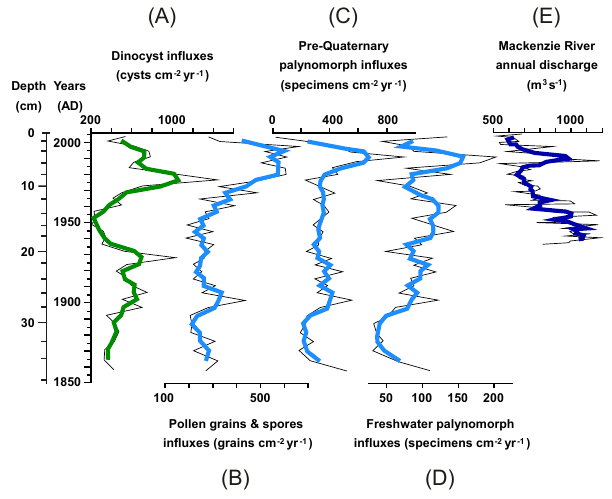
Fig. 4. Palynomorph fluxes in core MA680BC plotted against depth and age AD. Dinocyst fluxes (A) ; Pollen and spores fluxes (B) ; pre-Quaternary palynomorph fluxes (C) ; freshwater palynomorph fluxes (D) ; Mackenzie River annual discharge from 1938 to 2006 (HYDAT) (E) . The thick curves represent a running average over 3 data